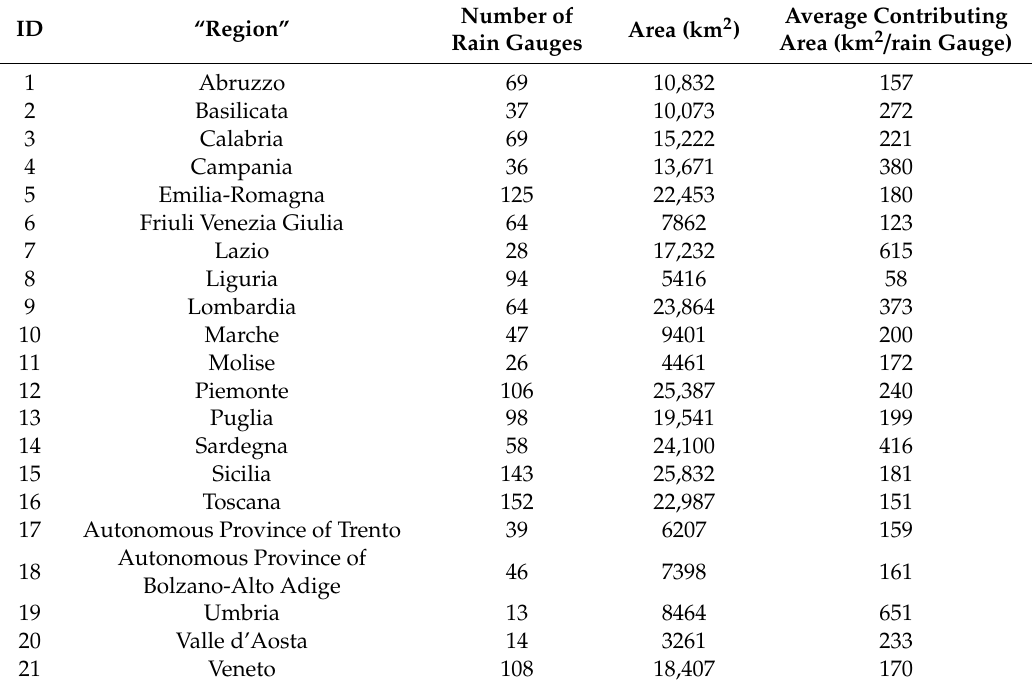
Table 3. Number of rain gauges with at least 30 years of measurements. The areas were derived from ISTAT data